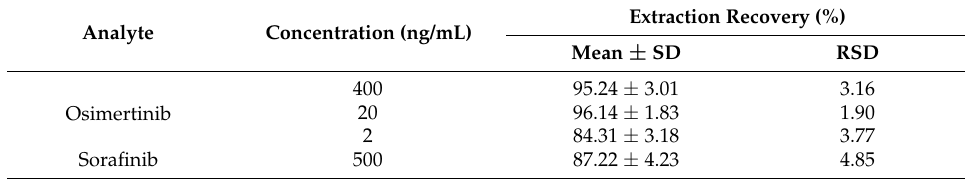
Table 2. Extraction recovery and matrix effect of osimertinib and IS in rat plasma.